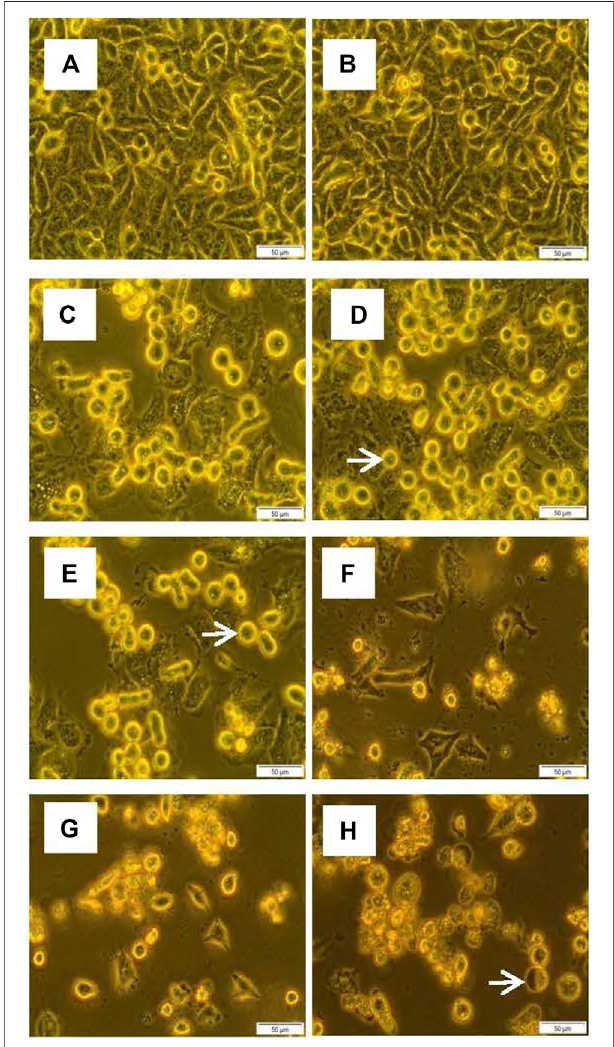
FIGURE 2 | Cell morphology of A549 cells after exposure to different doses of Thuja occidentalis homeopathic mother tincture (TO) and TO mediatedphotodynamictherapy(TO-PDT)underaninvertedlightmicroscope (x200 Magni fi cation). Figure 3(A) Untreated control, (B) Irradiation only, (C) 5 µlTO, (D) 10 µlTO, (E) 15 µlTO, (F) 5 µlTO-PDT, (G) 10 µlTO-PDT, (H) 15 µl TO-PDT. Scale bar 50 µm. White arrows indicate examples of rounded up dead cells.